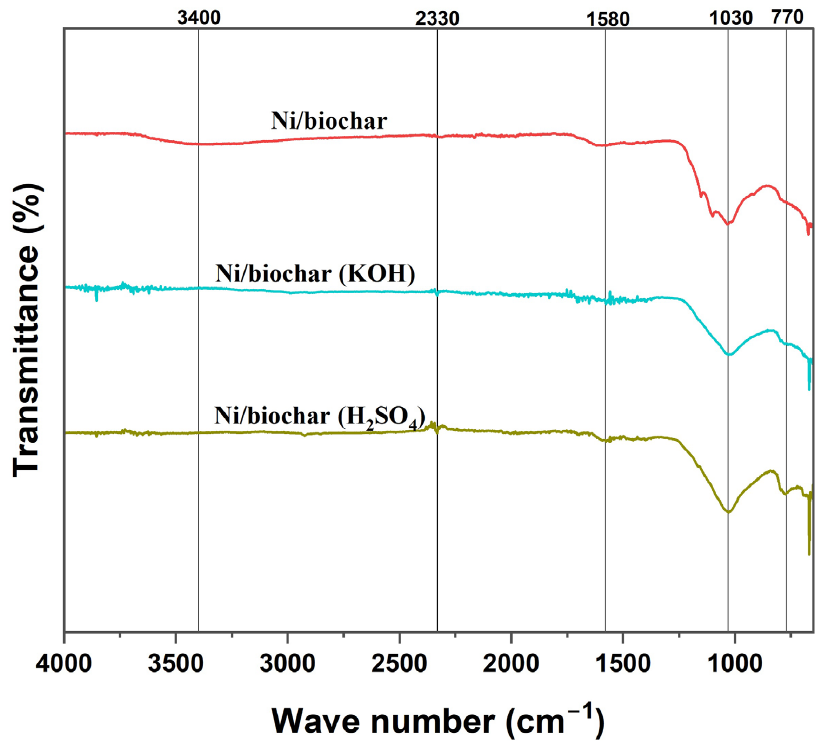
Figure 5. FTIR spectra of biochar, biochar (KOH), biochar (H 2 SO 4 ), and their corresponding Ni cat- alysts.